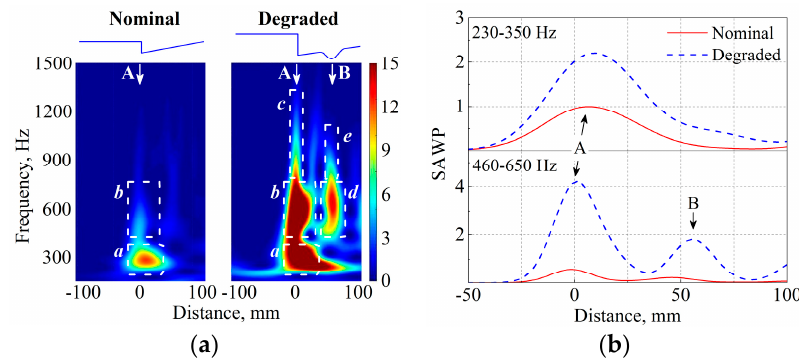
Figure 10. Comparison of the ABA at nominal and degraded states. ( a ) WPS and ( b ) SAWP. The rectangles indicate the major characteristics. Arrows A and B indicate the location of degradation types 1 and